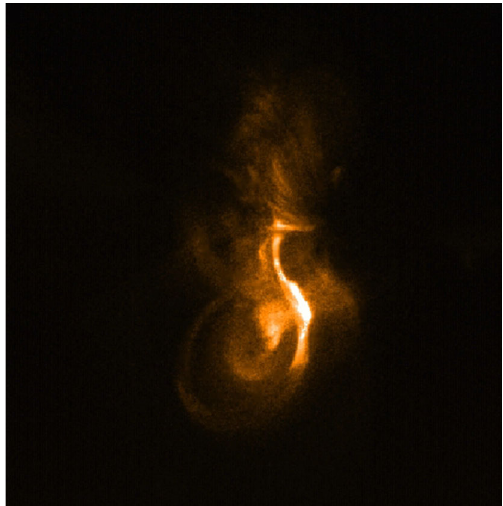
Fig. 24 Still from a movie: Hinode soft X-ray images observed on April 30, 2007. It shows an active region during two hours. Some small flares or microflares occurred; the largest was of class B2.6. Image courtesy of Antonia